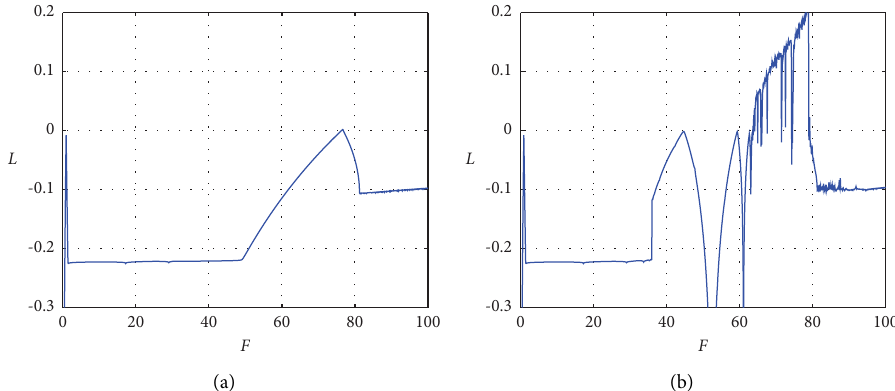
,x ) are close to 1 , 0 2 , 0